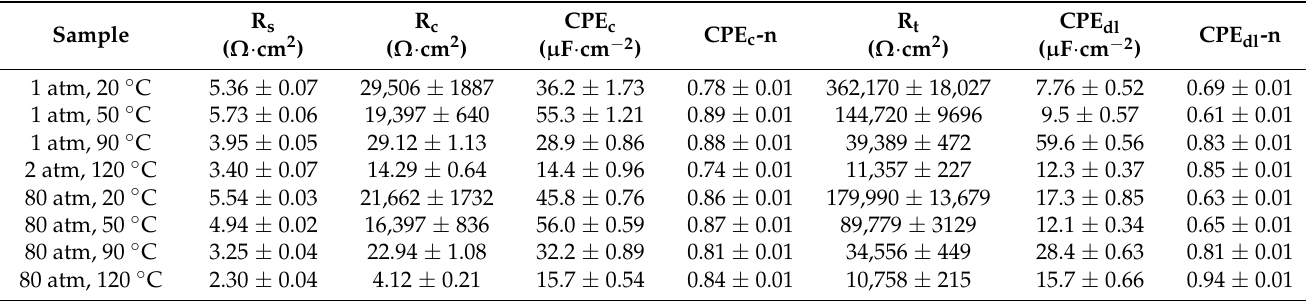
Figure 4. Nyquist plots ( a ), Bode impedance magnitude plots ( b ) and Bode phase angle plots ( c ) of the AMCs at normal pressure; Nyquist plots ( d ), Bode impedance magnitude plots ( e ) and Bode phase angle plots ( f ) of the AMCs at high pressure. The insets in ( b , e ) are the equivalent circuit model and schematic diagram of the AMCs. Table 2. EIS fitted results for the AMCs under various temperatures and pressures.